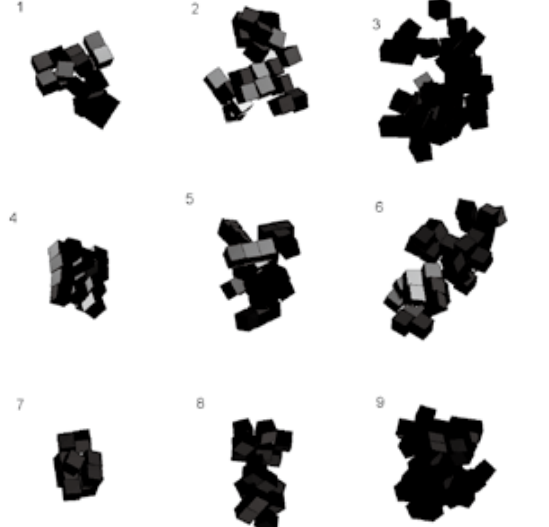
Fig. 8 Average compactness for aggregates with 15 primary particles per aggregate. To ensure a certain statistical relevance, data is only shown if at least 100 aggregates were available for